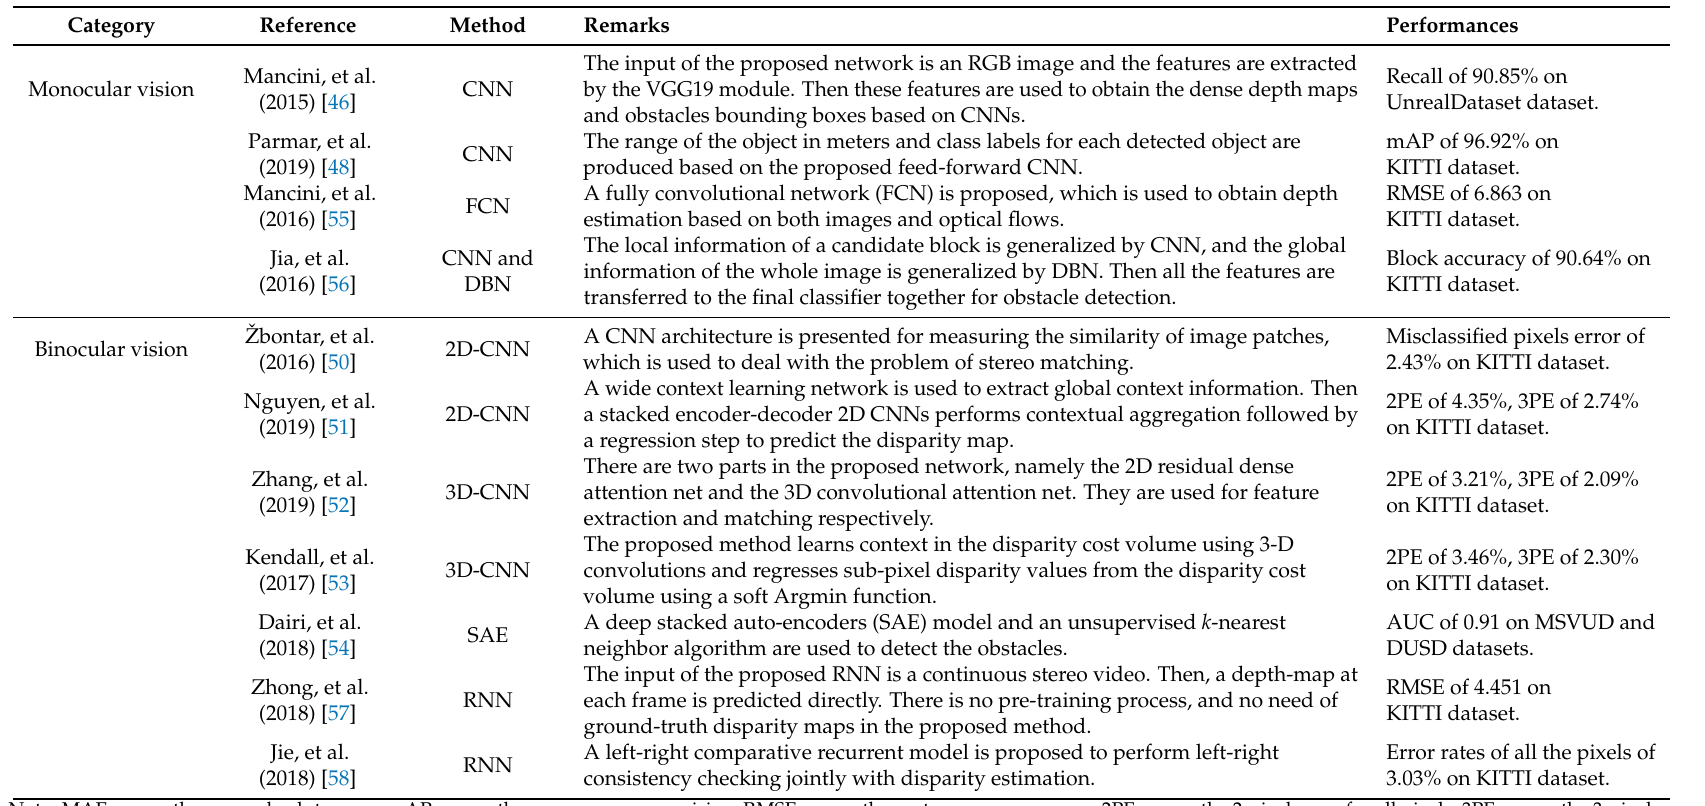
Table 1. A summary of the deep learning method-based obstacle detection